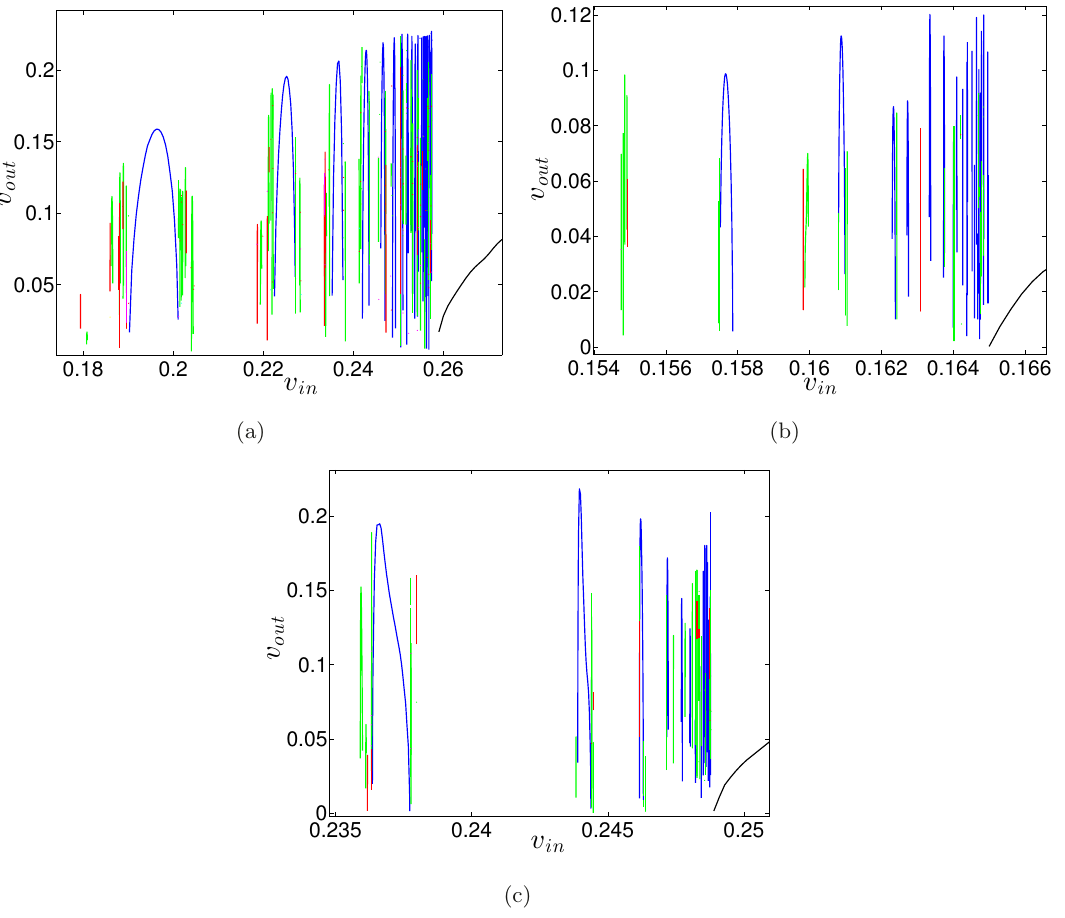
Figure 5 . The escape velocity v out as a function of the initial velocity v in when (a) ǫ = 20 (b) ǫ = 1 (c) ǫ = 0 . 5. Black represents a 1-bounce solution, blue represents a 2-bounce solution, green represents a 3-bounce solution, and red represents a 4-bounce